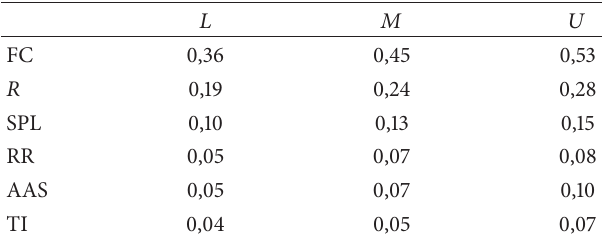
Table 6: Values of 𝑊 21